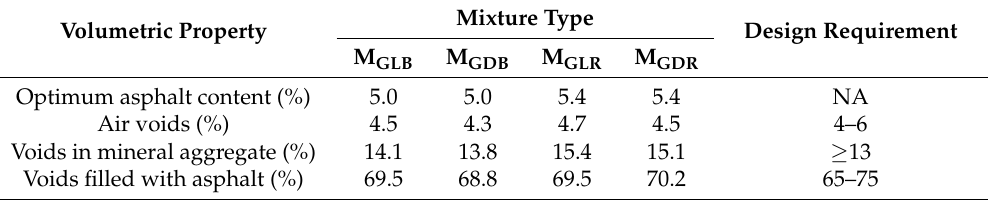
Table 6. Volumetric properties of designed asphalt mixtures.